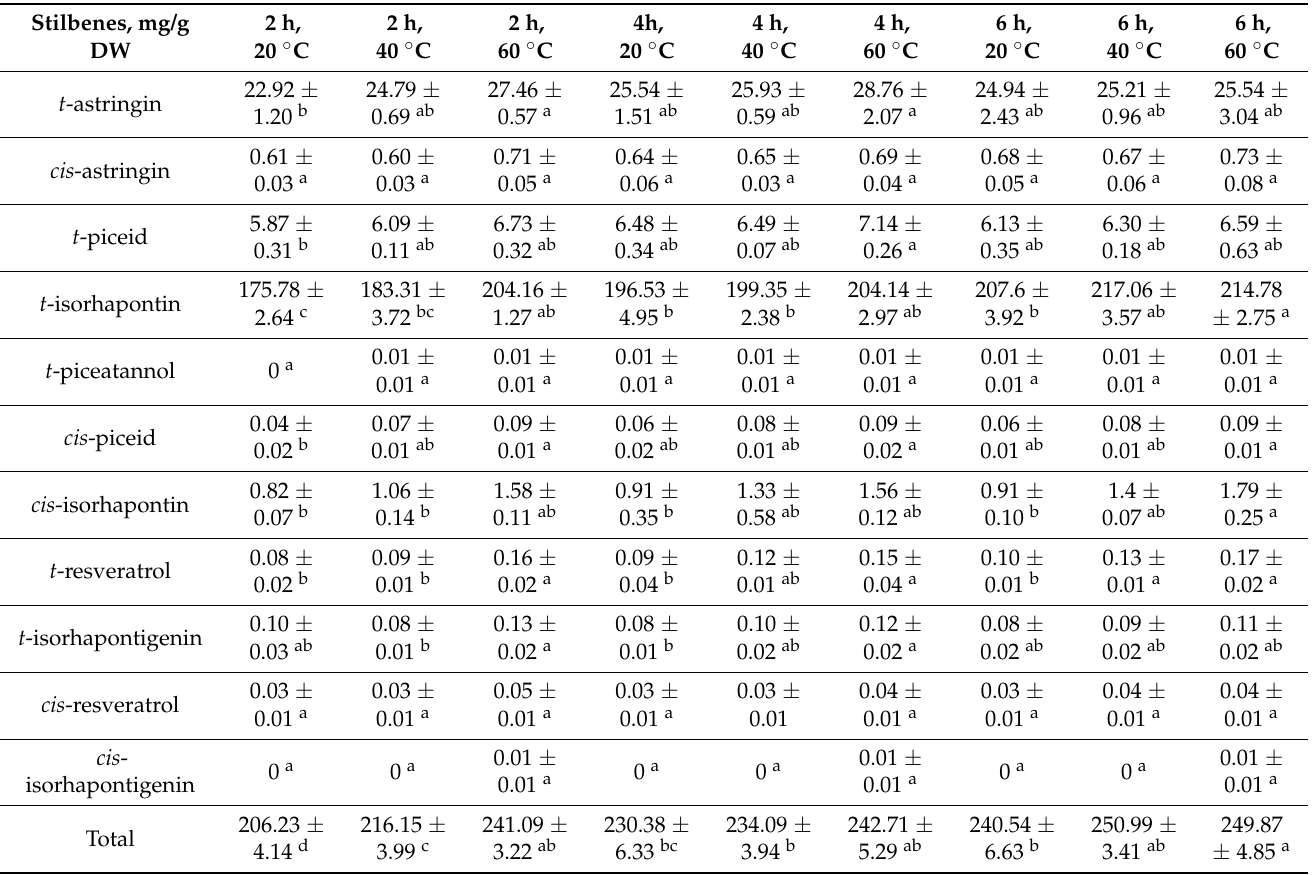
Table 3. Stilbene content in the bark of Picea jezoensis (mg per g of the dry weight (mg/g DW)) after using different extraction temperatures and times for stilbene analysis. Means followed by the same letter (a, b, c, d, ab, bc) in one row were not different using Student’s t -test (three independent experiments). Stilbenes were extracted using methanol from the bark of P. jezoensis harvested in winter. p < 0.05 was considered statistically significant.